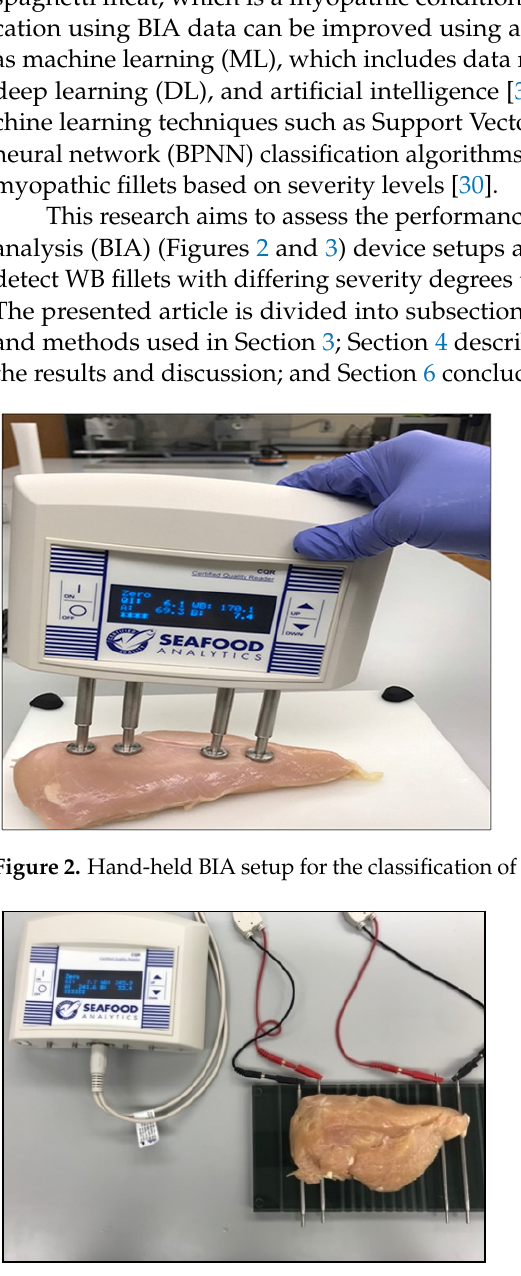
Figure 3. Plate BIA device for the classification of fillets based on severity level.